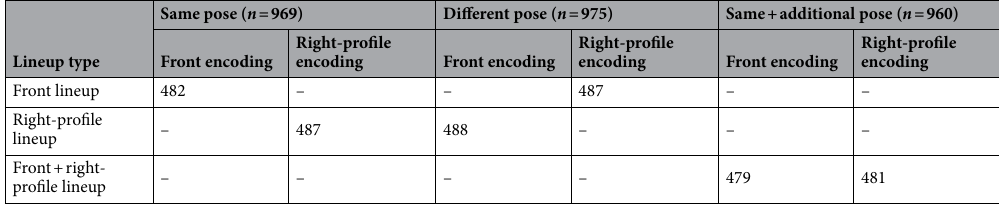
Table 1. Frequencies of participants in each pose condition by encoding group and lineup type in Experiment 1.